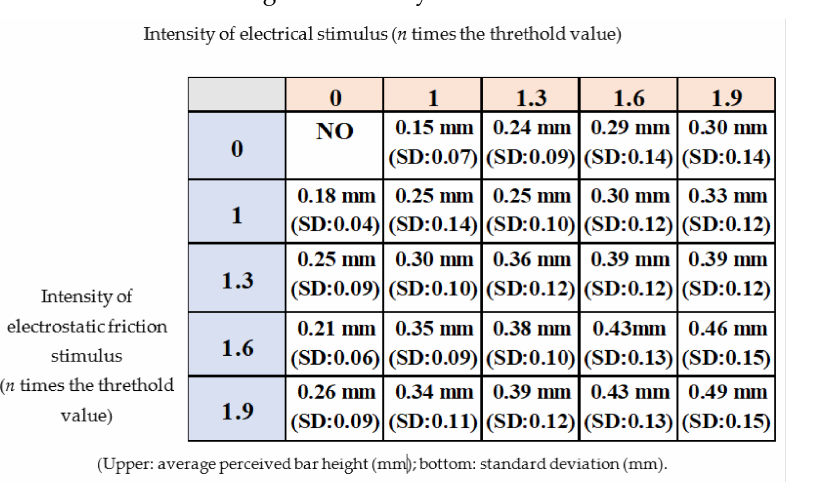
Figure 10. The height of the bar as perceived by the experimental participants.